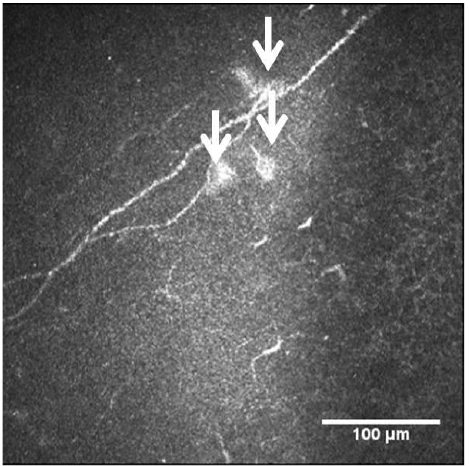
Figure 9. Neuromas in long COVID-19 patient seen with IVCM, white